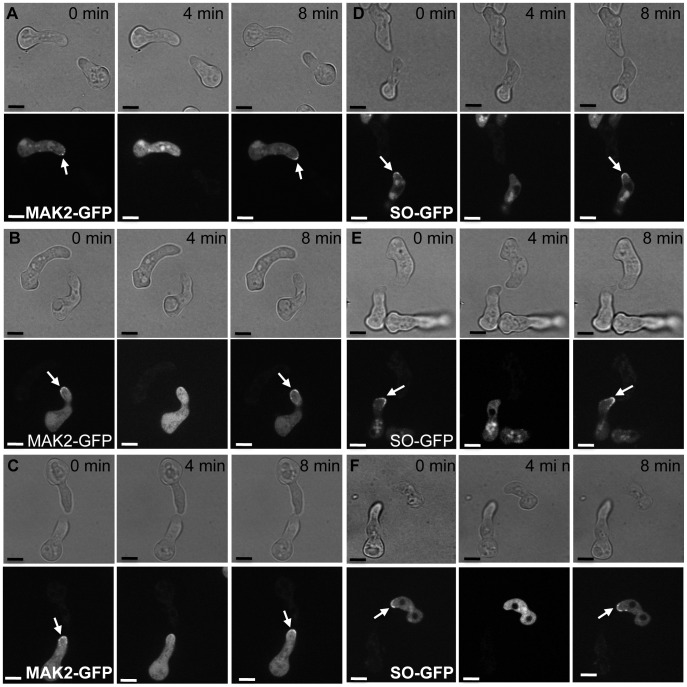
MAK2-GFP (A to C) and SO-GFP (D to F) oscillation in a wild type germling paired with Δcse-1 or Δnfh-2 germlings.Each panel shows frames from time-lapse visualization of one representative pair of germlings, in which one cell is a wild-type FGSC 2489 derivative expressing a communication protein tagged with GFP and the other cell is unmarked, of the FGSC 2489 background or a FGSC 2489 derivative harboring a single-gene deletion (Δ). Arrows show localization of MAK2 to CATs in panels A–C and SO localization to CATs in panels D–F. (A) Oscillation of MAK2-GFP in a wild-type germling (his-3::Pccg1 mak-2-gfp; Δmak-2) when paired with unmarked wild type germling. All germlings participating in chemotropic interactions showed oscillation of MAK2. (B) Oscillation of MAK2-GFP in a wild-type germling (his-3::Pccg1 mak-2-gfp; Δmak-2) when paired with an unmarked Δcse-1 mutant, in one of the rare instances in which chemotropic interactions were observed. (C) Oscillation of MAK2-GFP in a wild-type germling (his-3::Pccg1 mak-2-gfp; Δmak-2) when paired with a nfh-2 germling in one of the few cases where chemotropic interactions were observed. (D) Oscillation of SO-GFP in a wild-type germling (his-3::Pccg1 SO-gfp; ΔSO) when paired with unmarked wild-type germling. Oscillation of SO was observed in all wild type-germlings participating in chemotropic interactions. (E) Oscillation of SO-GFP in a wild-type germling (his-3::Pccg1 SO-gfp; ΔSO) when paired with an unmarked Δcse-1 germling, in a case in which chemotropic interactions were observed. (F) Oscillation of SO-GFP in a wild-type germling (his-3::Pccg1 SO-gfp; ΔSO) when paired with unmarked Δnfh-2 germling, in one of the few cases in which chemotropic interactions were observed. Scale bar = 5 µm.